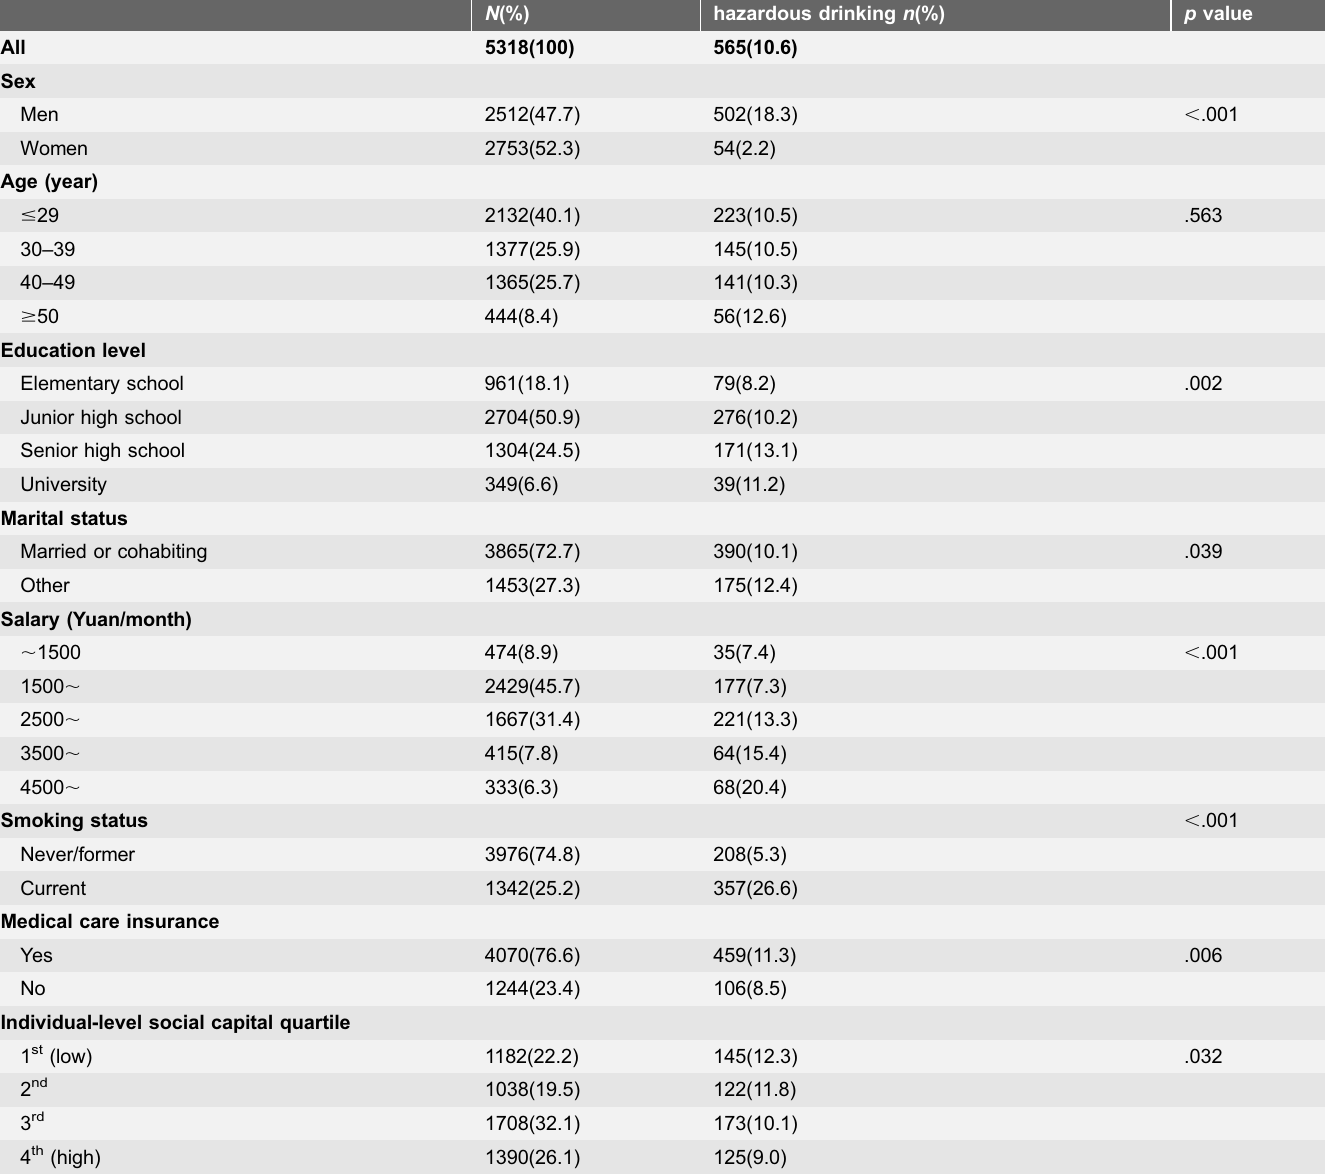
Table 1. Demographic characteristics and hazardous drinking of the study